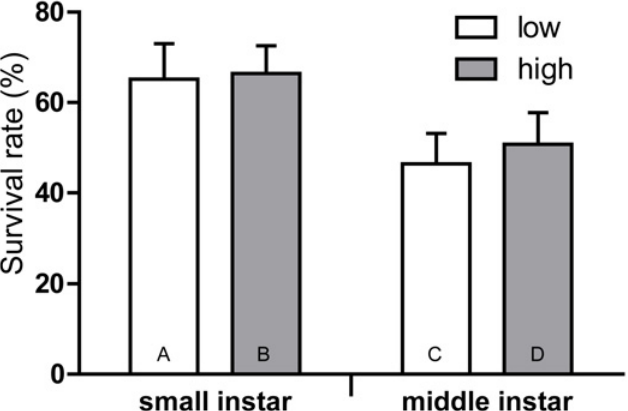
Fig 3. Survival rate of larvae reared on Betula pendula leaves with different concentrations of surface lipophilic compounds. Bars are mean ± SE. The data were pair-wise compared using a post-hoc Fisher LSD procedure. The letters above the bar mean the significant differences (at P < 0.05) to be compared with the bars abbreviated by the same letters within the bar.